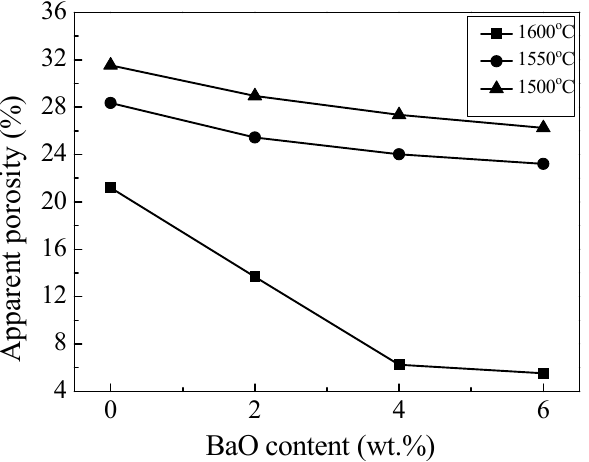
Figure 1. Apparent porosity of the samples with BaO addition sintered at different temperatures in air.